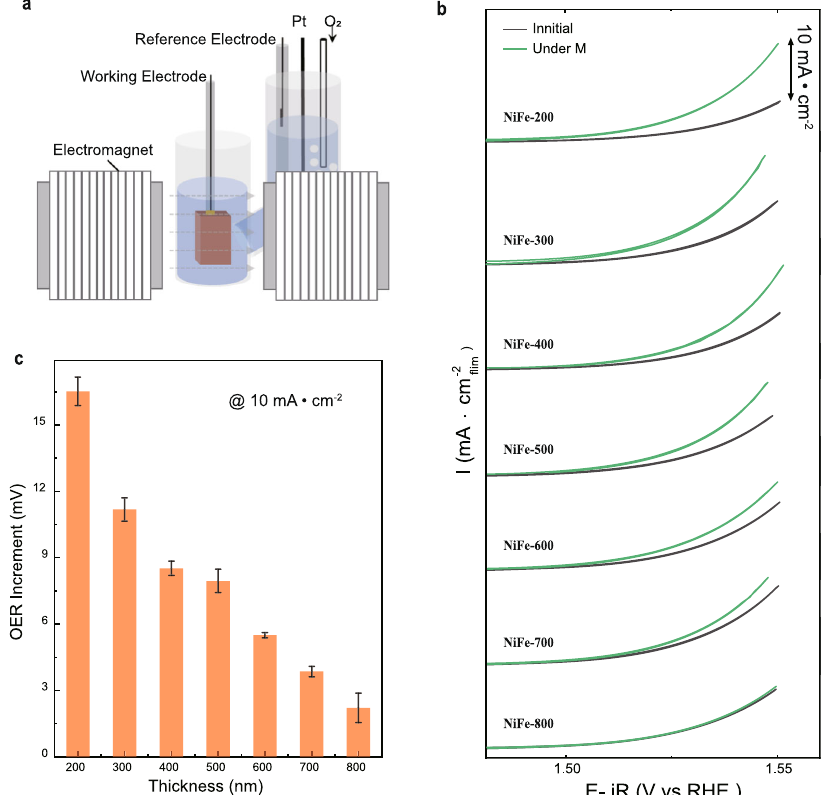
Fig. 3 | Magnetization enhanced OER. a The schematic illustration of the experimentalset-upforelectrochemicalmeasurementsunderaconstantmagnetic fi eld. b Cyclic voltammetry (CV) of NiFe thin fi lms with different thicknesses at a scan rate of 10mVs − 1 in O 2 -saturated 1.0M KOH with and without a constant in-